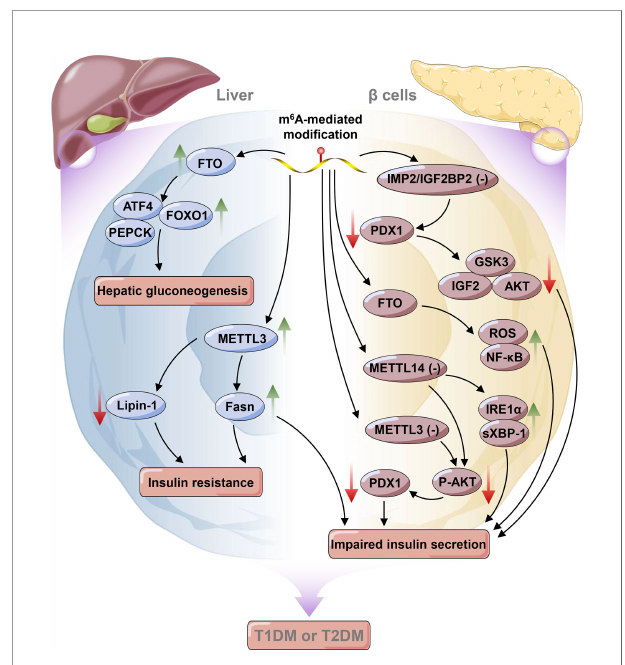
FIGURE 2 | Epitranscriptomicregulatory mechanismsinliver and pancreatic b cells in diabetes mellitus. The green arrow indicates an increasein the change, whereas thered arrow indicates a decrease inthe change. METTL3 , Methyltransferase-like 3; FTO , Fat mass and obesity-associatedprotein; PEPCK , Phosphoenolpyruvate arboxynase; FOXO1 , Forkheadbox O1; ATF4 , Activating transcription factor4; Fasn , Fatty acid synthase; PEPCK , Phosphoenolpyruvate carboxynase; IGF2 , Insulin-likegrowth factor2; IMP2/IGF2BP2 , IGF2 mRNA binding protein 2; PDX1 , Pancreatic duodenal homeobox 1; GSK3 , Glycogen synthase kinase-3; ROS , Reactive oxygen species; IRE1 a , Inositol-requiring enzyme 1 alpha; XBP-1 , X-box binding